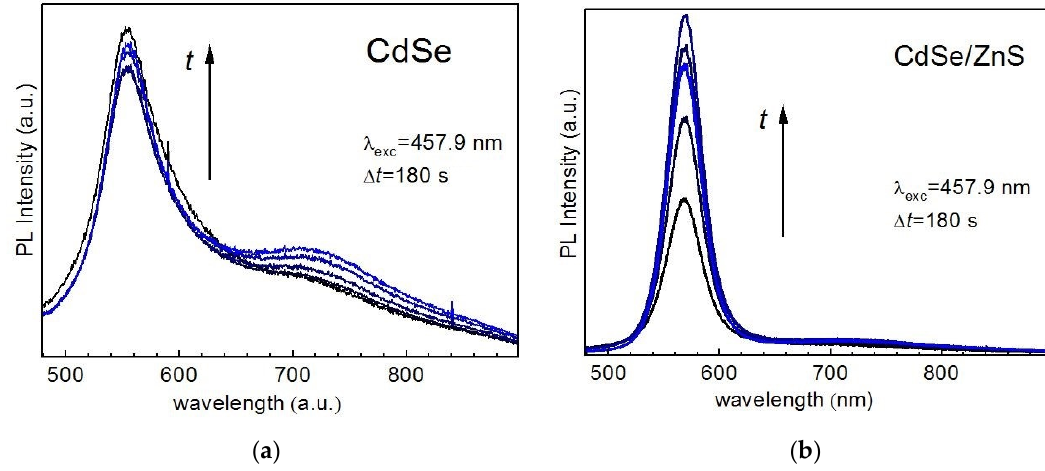
Figure 6. ( a ) Time evolution (from black to blue) of the PL intensity of CdSe ( a ) and CdSe/ZnS ( b ) NCs in gelatin matrix at λ exc = 457.9 nm (0.1 W/cm 2 ).